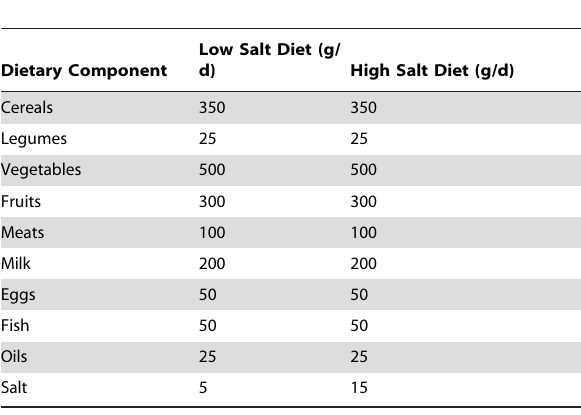
Table 1. Dietary Components Used to Construct Low and High Salt